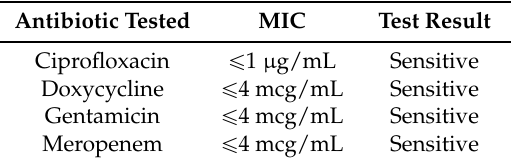
Table 1. Antibiotic susceptibility testing of the isolated